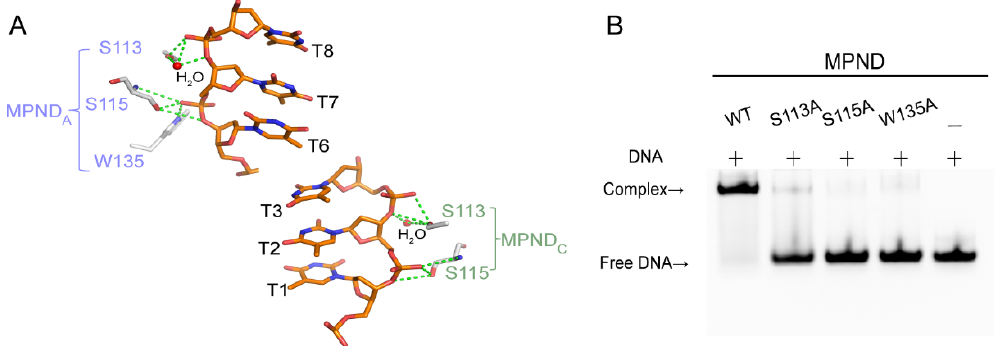
Figure 4. Interaction of MPND and dsDNA. ( A ) Close-up view of the interaction between key residues and DNA bases. ( B ) The EMSA of different MPND mutants with the DNA.